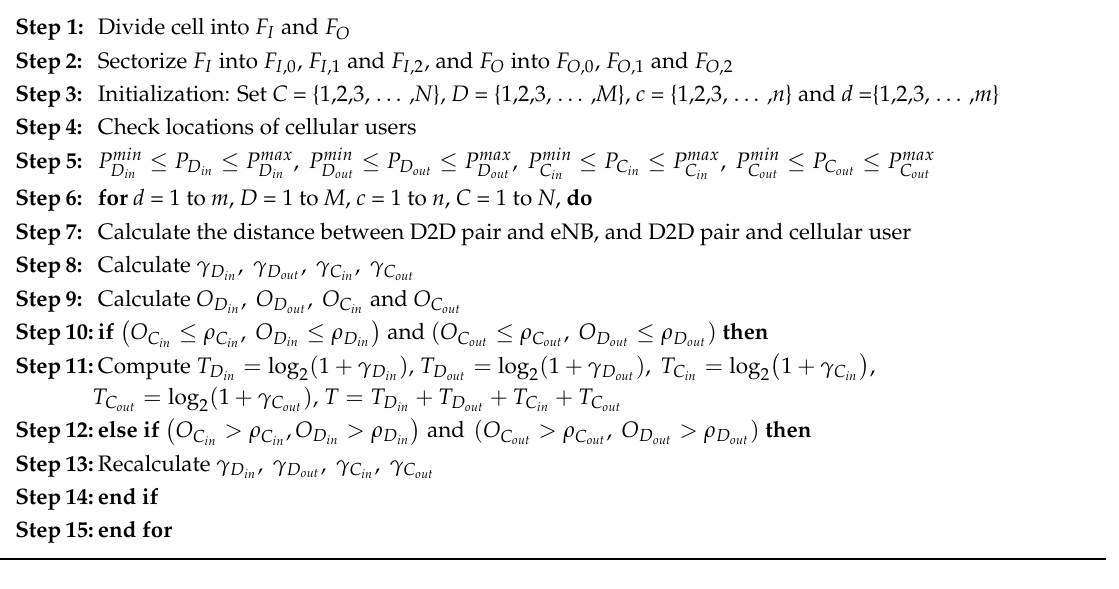
Algorithm 1 Working of the Proposed Resource Allocation and Power Control